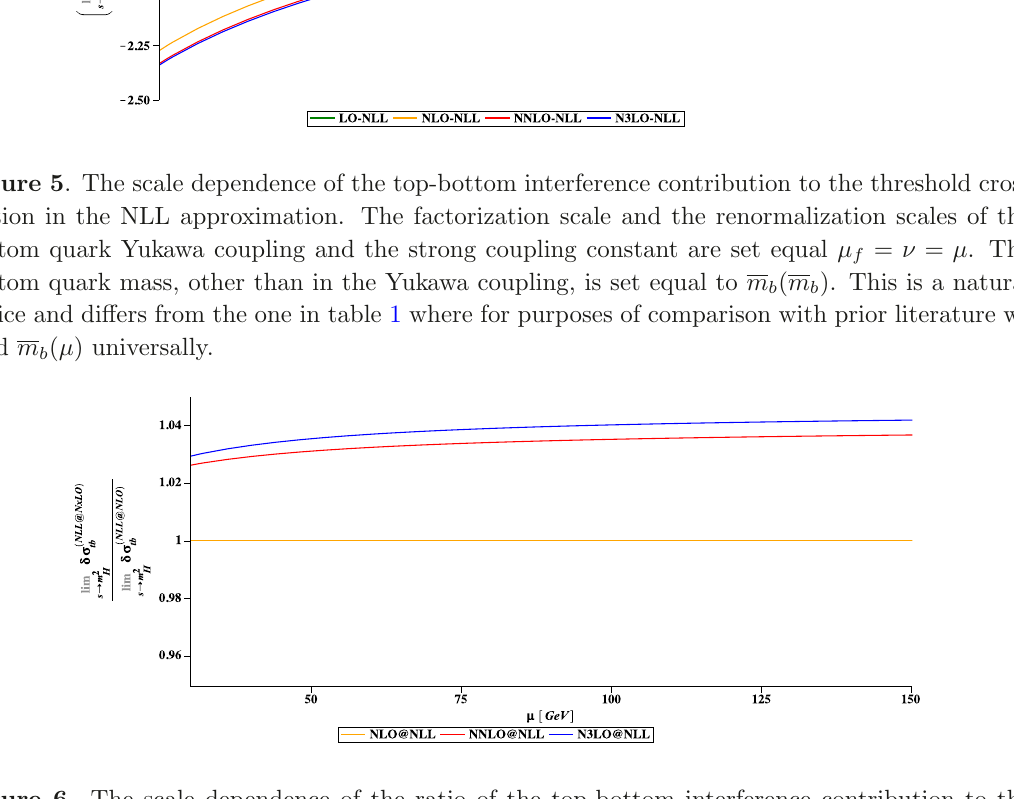
Figure 6 . The scale dependence of the ratio of the top-bottom interference contribution to the threshold cross section to the NLO result through N 3 LO in the NLL approximation. The factor- ization scale and the renormalization scales of the bottom quark Yukawa coupling and the strong coupling constant are set equal µ f = ν = µ . The bottom quark mass, other than in the Yukawa coupling, is set equal to m b ( m b